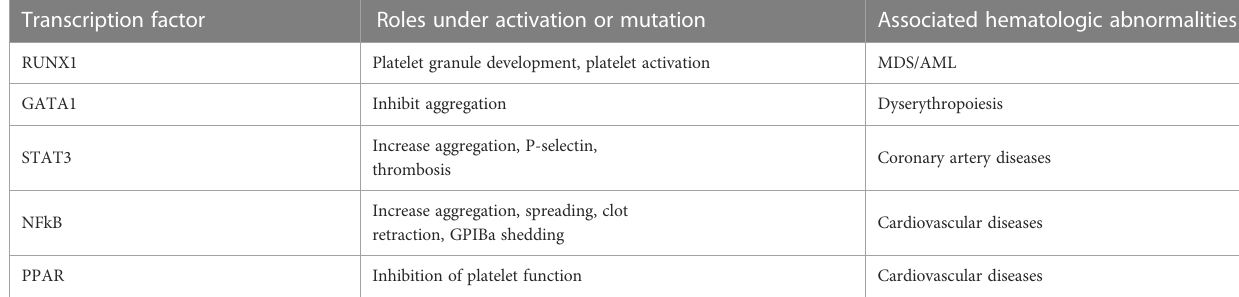
TABLE 1 Roles of transcription factors in